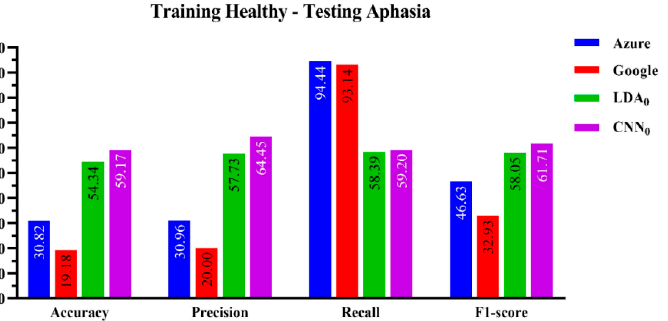
Figure 3. Performance evaluation of the four-machine learning-based algorithms on the joint healthy-aphasic dataset.